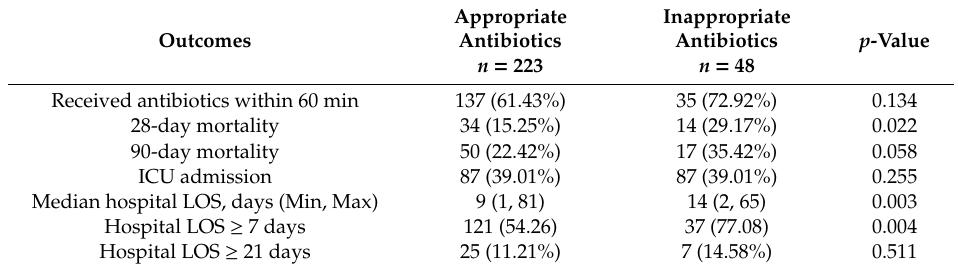
Table 4. Clinical outcomes of patients presenting with bacteremia at the emergency department who were given appropriate and inappropriate antibiotic